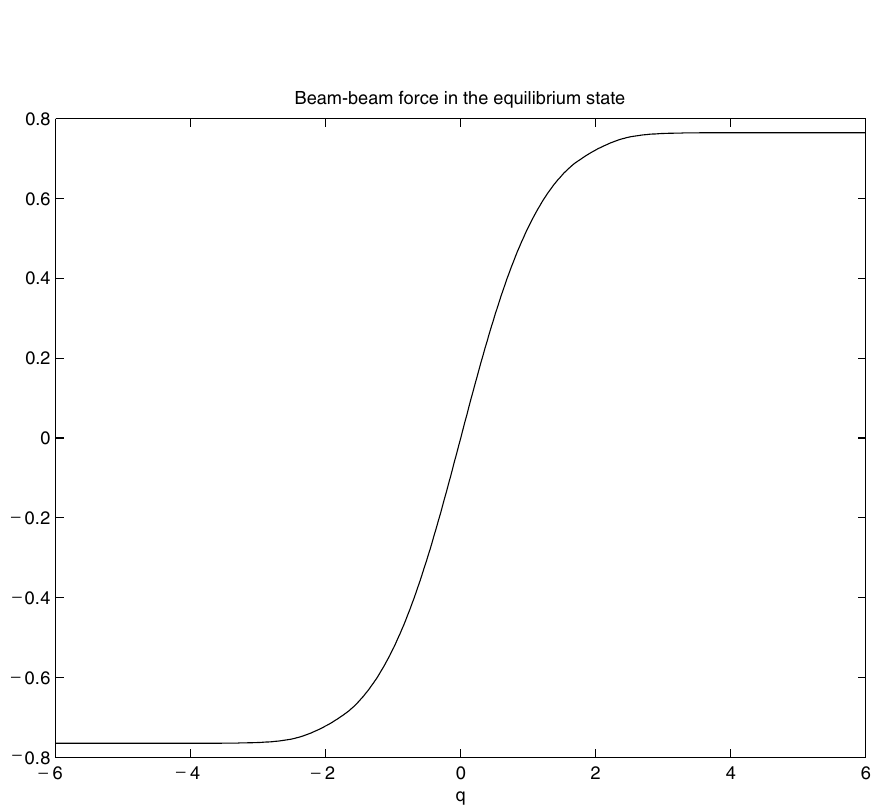
, first 30000 turns. q